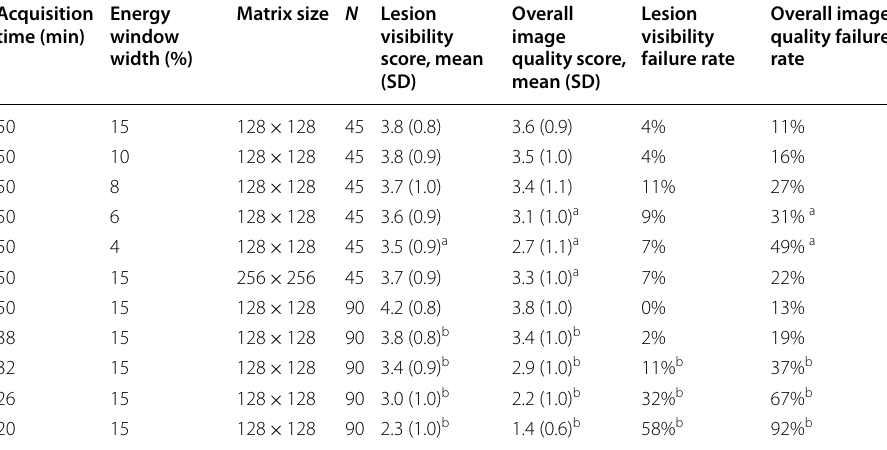
Table 1 Scores and failure rates for lesion visibility and image quality with different acquisition